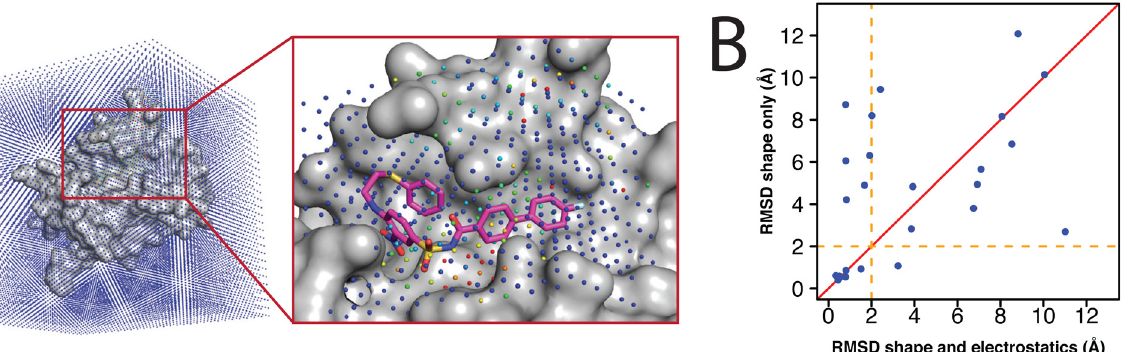
Fig 5. Incorporation of electrostatic complementarity into DARC 2.0. (A) The electrostatic potential is evaluated at a series of grid points over the whole protein using the finite difference Poisson-Boltzmann solver included in OpenEye ’ s ZAP toolkit [45]. We use trilinear interpolation of the closest gridpoints to determine the electrostatic potential at points corresponding to locations of ligand atoms, and then use the ligand partial charges to compute the electrostatic interaction energy (Eq 3). (B) For each protein-ligand complex in our set (S1 Table), we used DARC to dock the ligand back into its cognate receptor either with or without including the electrostatic complementarity term. In both cases, leave-one-out cross-validation was used to ensure the weights were not overfit to the training set. Each point represents a separate complex; points above the diagonal are those for which inclusion of electrostatics led to better pose